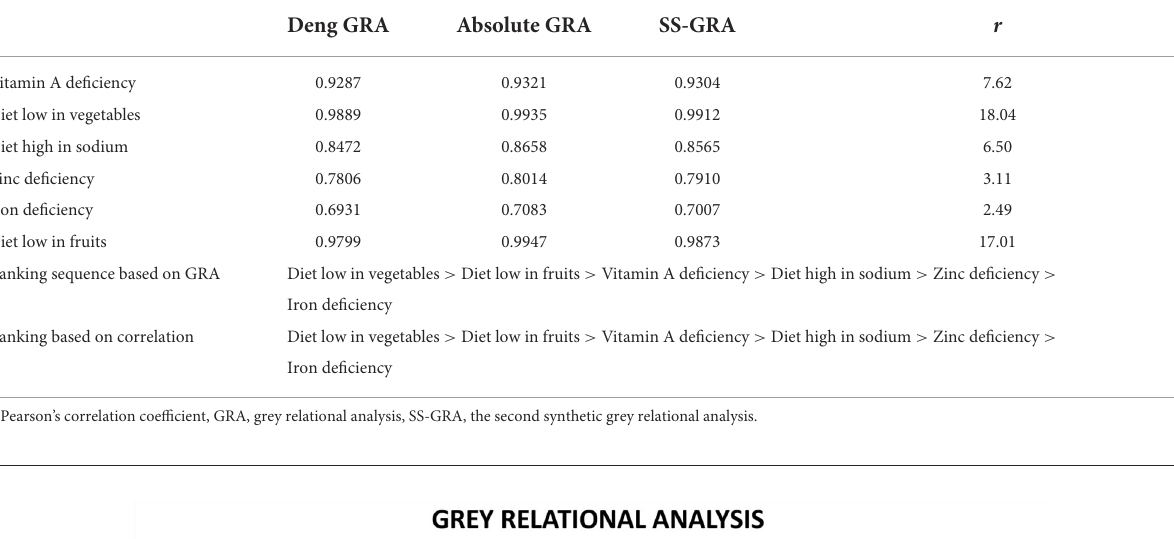
TABLE 1 Grey relational assessment for IHD morbidity with nutritional risk factors.